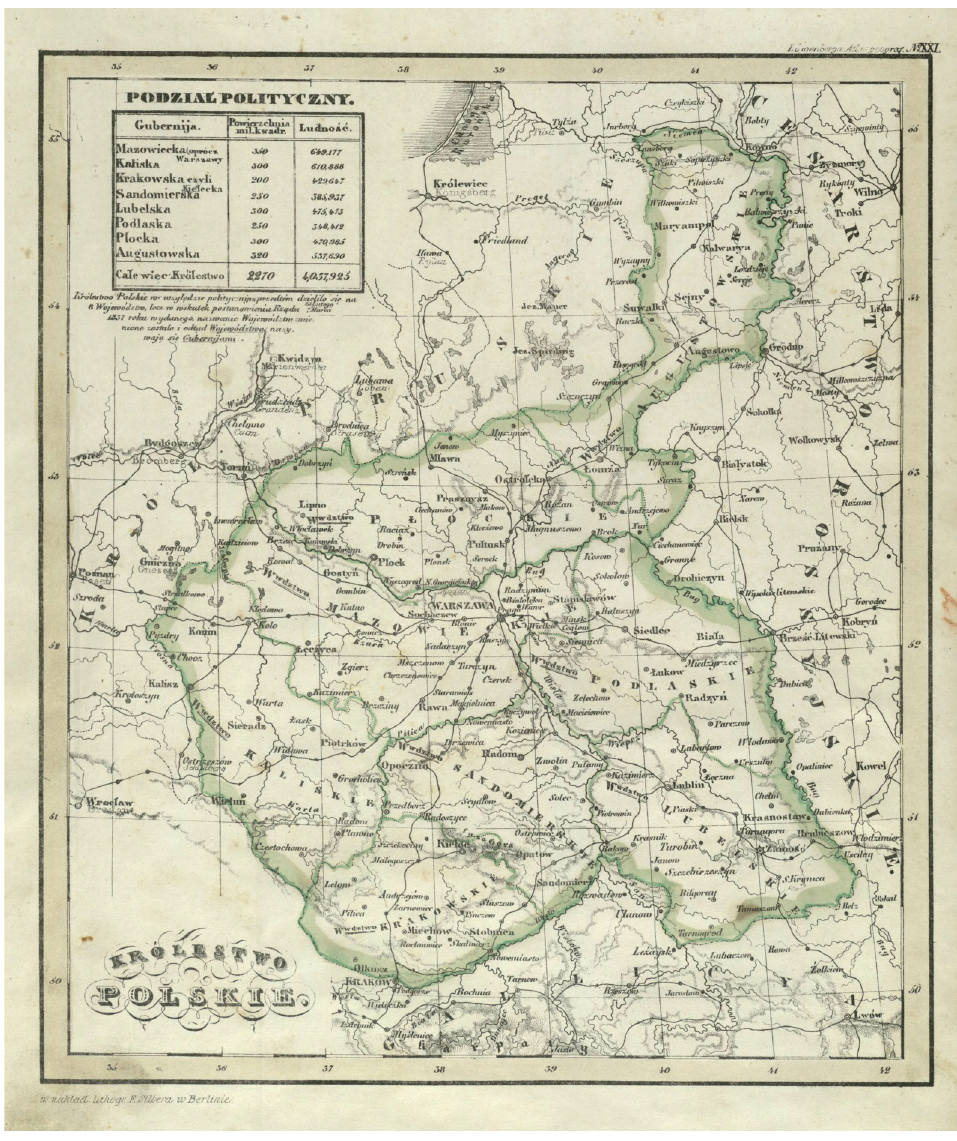
Fig. 2. The map of the Polish Kingdom from Atlas geograficzny dla użytku szkolnego i prywatnego... (The geographical atlas for school and personal use) by J. Loewenberg (source: KUL Digital